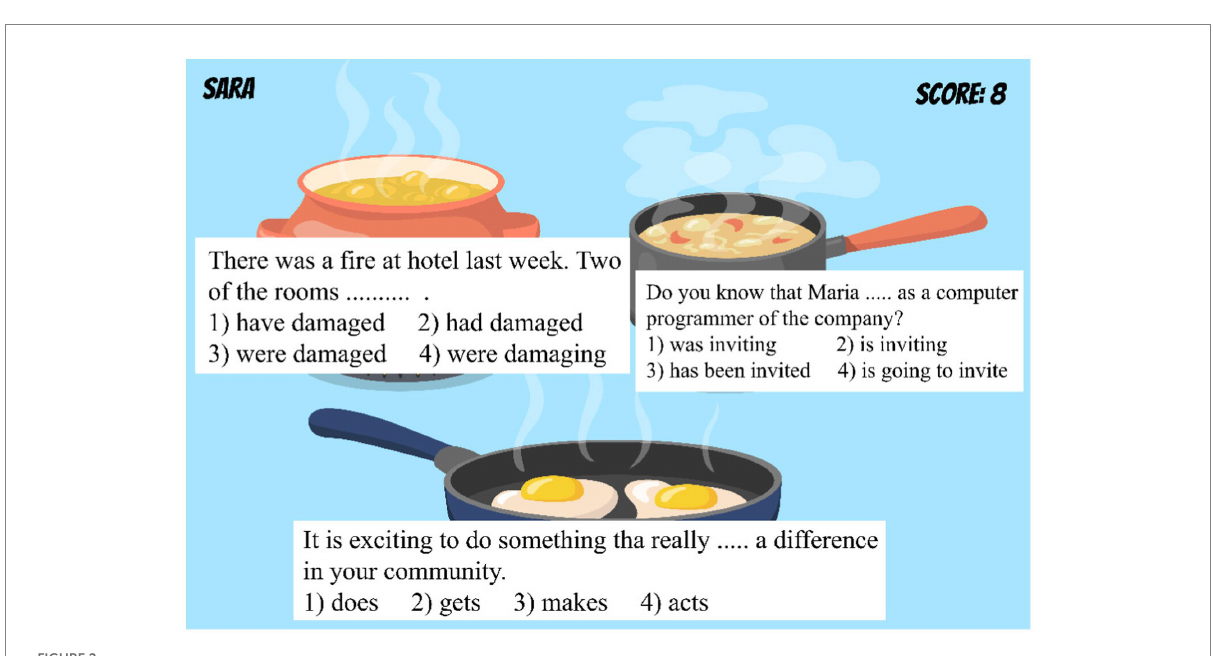
FIGURE 1 Results of the correct and wrong answers.